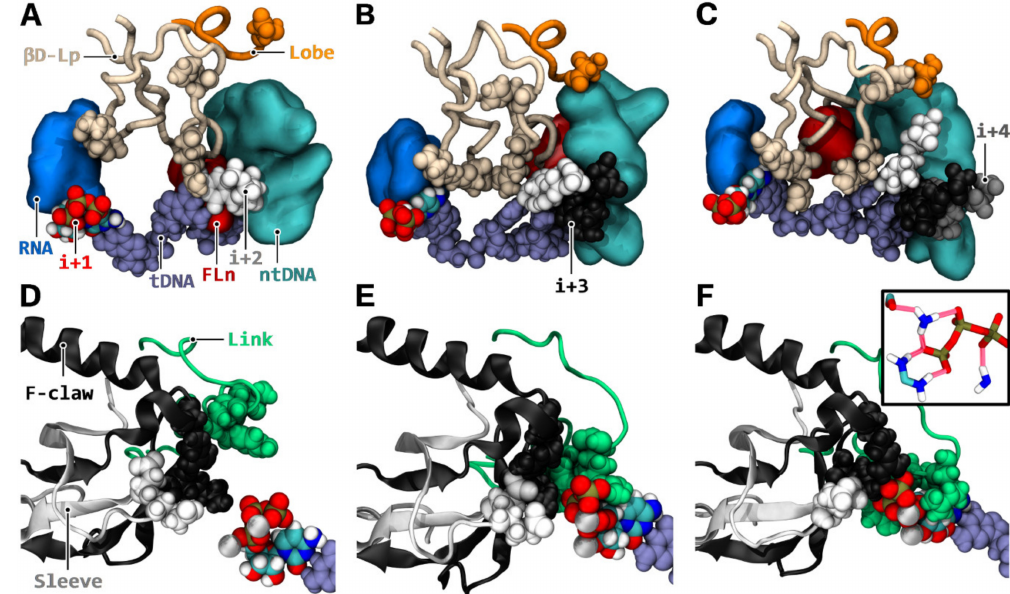
Figure 8. Mechanistic reorganizations associated with downstream binding. Left ( A,D ), middle ( B,E ), and right ( C,F ) columns: respective simulated configuration after 100 ns with i + 2 (aMD_M1); i + 2 /+ 3 (aMD_M2); and i + 2 /+ 3 /+ 4 (aMD_M3) NTPs paired to template DNA. Template DNA (fade blue van der Waals spheres) is represented from i + 4 to i + 1 ( A – C ) or sole i + 1 ( D – F ) positions. Active site i + 1 NTP is colored by atomic type. i + 2, i + 3, and i + 4 NTPs ( A – C ) are in white, black, and grey van der Waals spherical representation, respectively. ( A – C ) Coupling of downstream binding to β D loop reorganization. β D loop, RPB2 483–527 (beige tube), lies in between template DNA, non-template DNA (cyan surface, represented from i − 1 to i + 6), and RNA (medium blue surface, represented from i to i − 2). Fork loop 2 N-TER segment RPB2 491–494 (red surface) is represented. C-TER portion of the lobe domain RPB2 384–392 is shown as an orange tube. Lobe β D loop interacting residue 2 D384 is shown in van der Waals representation. β D loop junction residues are shown as follows: 2 H502 (top), 2 R499 (right), and 2 E516 / 2 G517 / 2 H518 (left); ( D – F ) The distortion of template DNA is propagated to i + 1 bound NTP (MgA and MgB ions are represented in silver), which flips towards link RPB2 713–737 (green), F claw RPB2 928–992 (black), and sleeve RPB2 772–807 (white) domains. Highlighted in van der Waals representation are the following NTP surrounding residues: link ( 2 R721, 2 Y724, and 2 T723), F claw ( 2 R975 and 2 K942), sleeve ( 2 E791 and 2 D792); ( F inset ) The NTP triphosphate group is